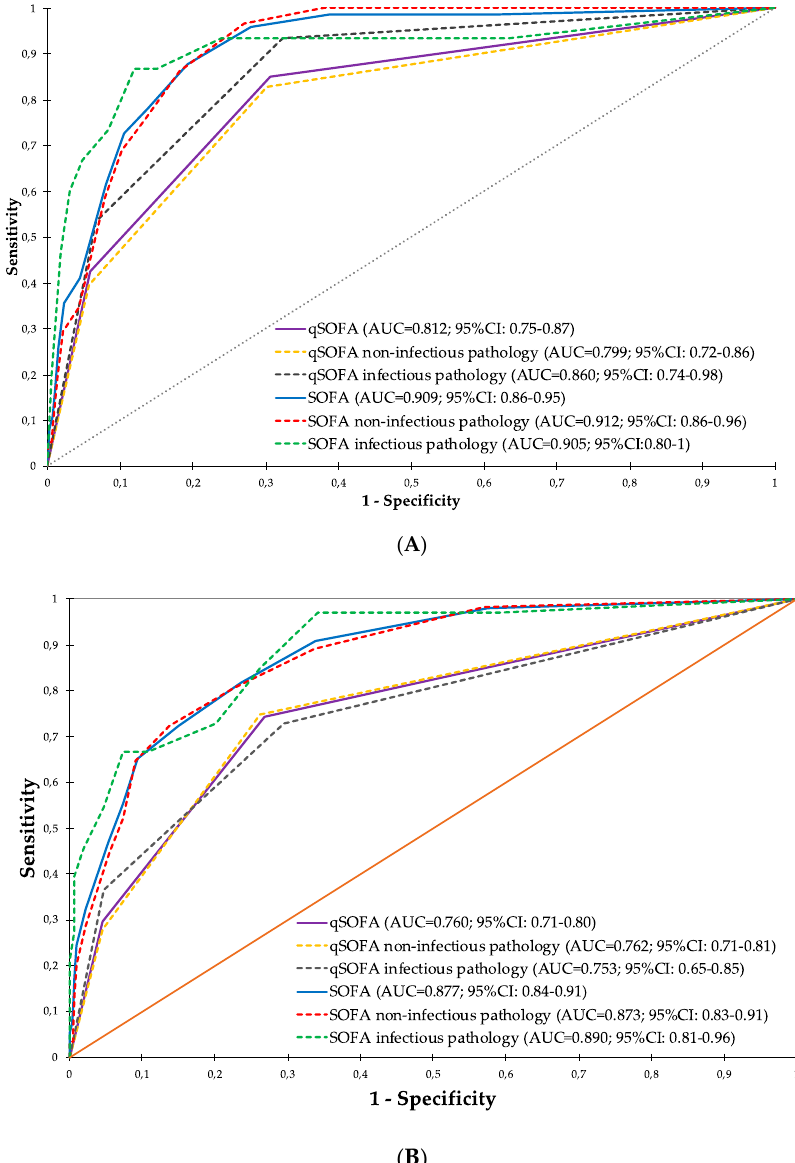
Figure 2. Diagnostic performance curves and areas under the curve with 95% confidence intervals for qSOFA and SOFA, globally, for non-infectious and infectious pathologies. ( A ) Two-day mortality; ( B ) 30-day mortality (in all cases p < 0.001). qSOFA: quick sequential organ failure assessment score; SOFA: sequential organ failure assessment